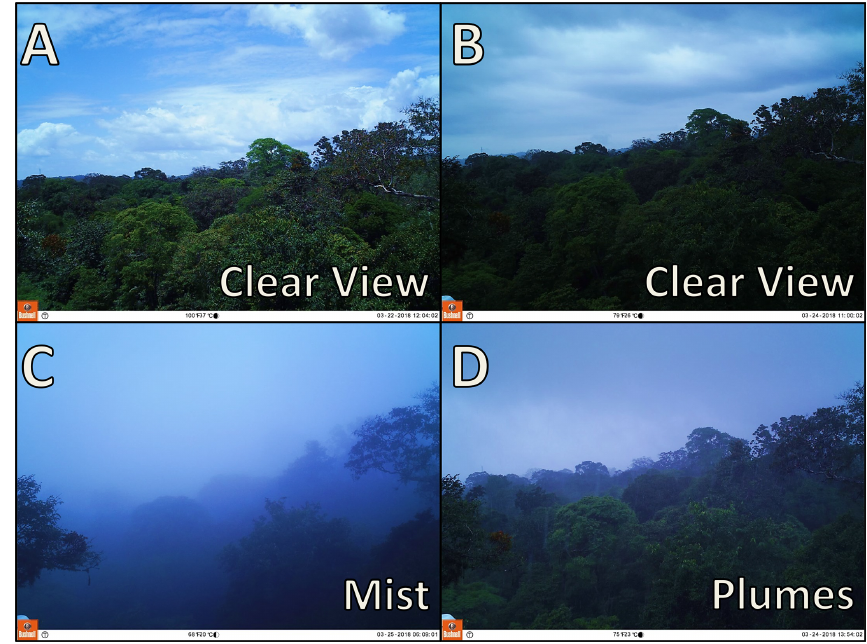
Figure 2. Visual monitoring showing the three conditions used to classify the canopy photographs on the time-lapse videos. The pictures (a) and (b) show the clear view classification, with picture (a) on a sunny day and picture (b) during rain. Picture (c) describes the mist and picture (d) shows the plumes rising from the forest canopy.